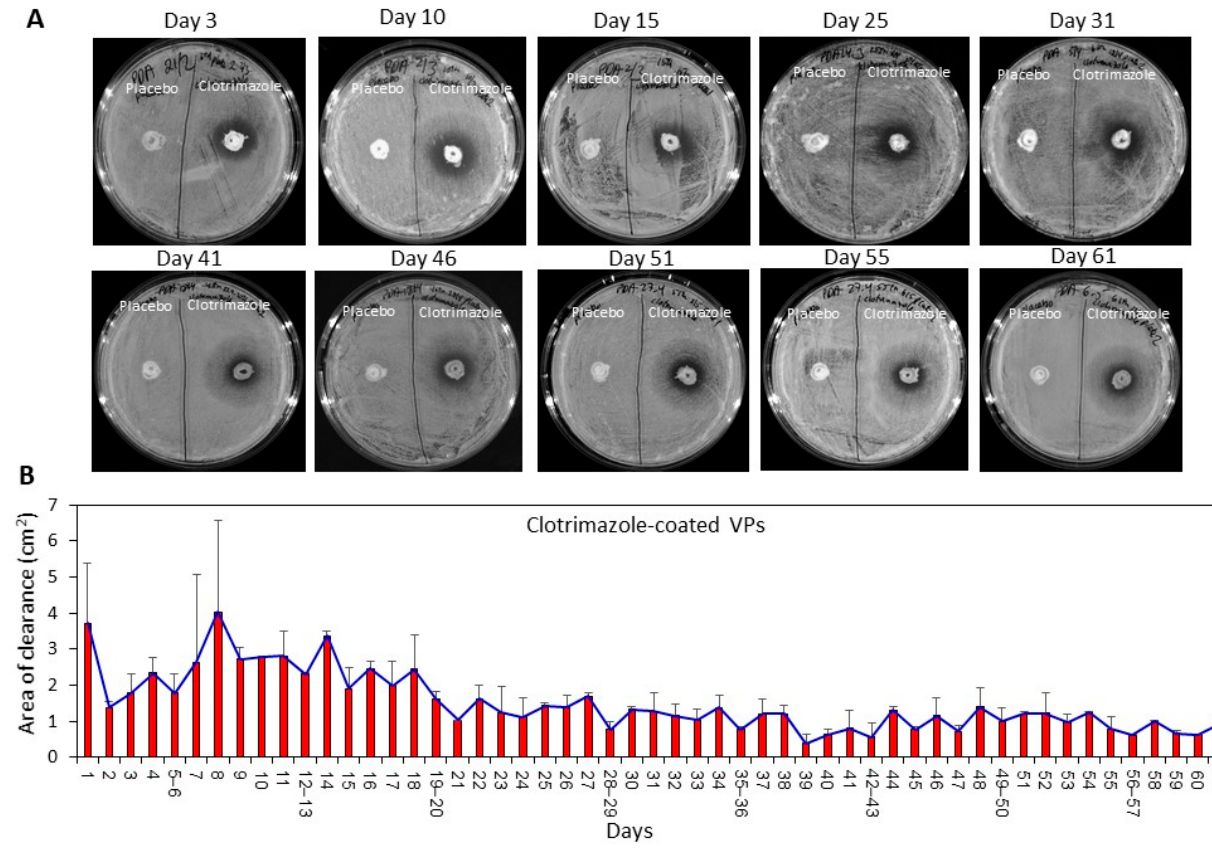
Figure 2. SRV-CTZ-coated VPs prevented fungal growth in its vicinity for long periods of time. ( A , B ) SRV-CTZ- and placebo-coated VPs were daily placed on C. albicans -coated agar plates ( A ), and the clearance area determined ( B ). The placebo-coated VPs did not cause any clearance of the fungi. N = 2.